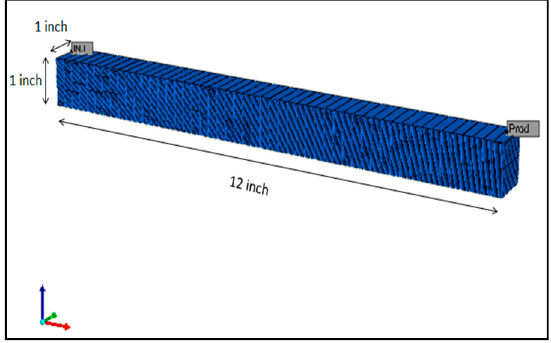
Figure 2. Single porosity reservoir model used in the simulation study. Table 4. Composition of the oil used in fluid model.